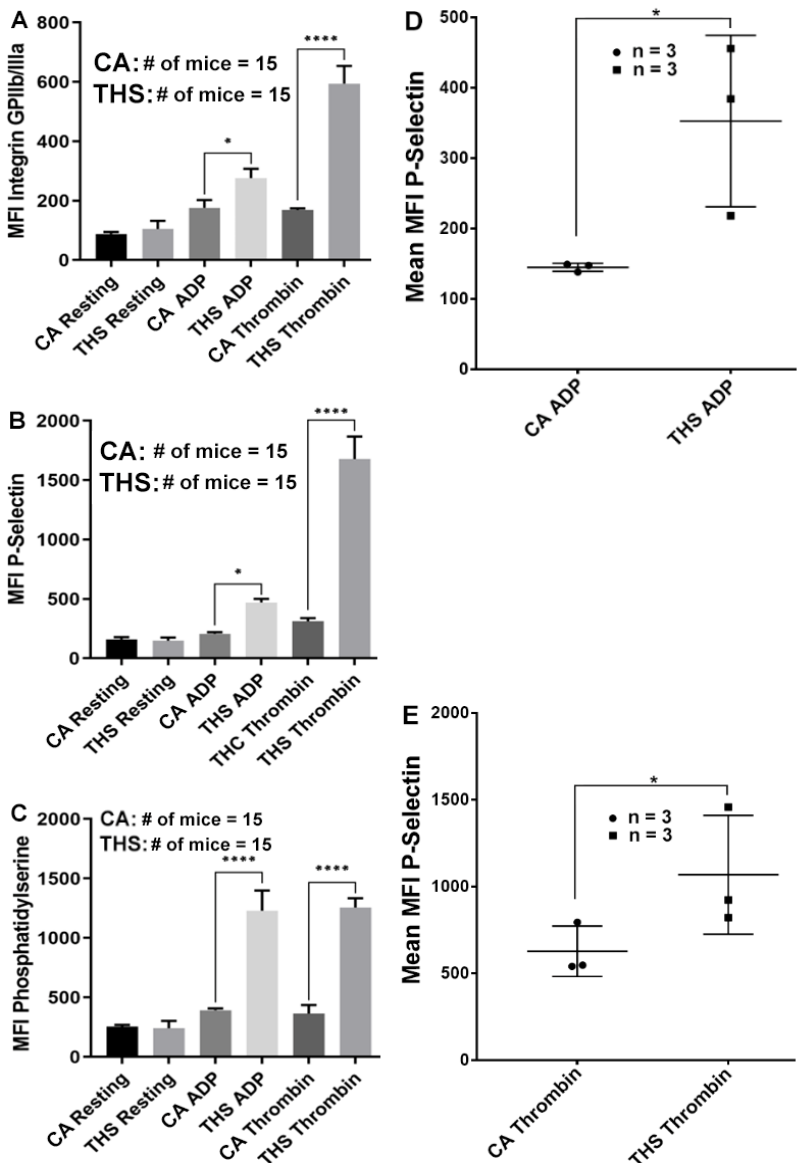
Figure 3. THS-exposed platelets show increased integrin α IIb β 3, P-Selectin and phosphatidylserine expression. THS-exposed and CA-exposed platelets were stimulated with either thrombin (0.1 U/mL) or ADP (1 µ M) for 5 min, and processed for ( A ) integrin α IIb β 3, ( B , D , E ) P-Selectin, ( C ) phosphatidylserine expression as described in the Methods section. Results are expressed as the mean fluorescence intensity (MFI) or mean of the MFI ( D , E ) by flow cytometry. Each experiment was repeated three times with blood pooled from at least five THS-exposed and CA-exposed mice (( A – C ); * p < 0.05; **** p < 0.0001) or with blood from a single mouse for a total of three mice (( D , E ); * p <